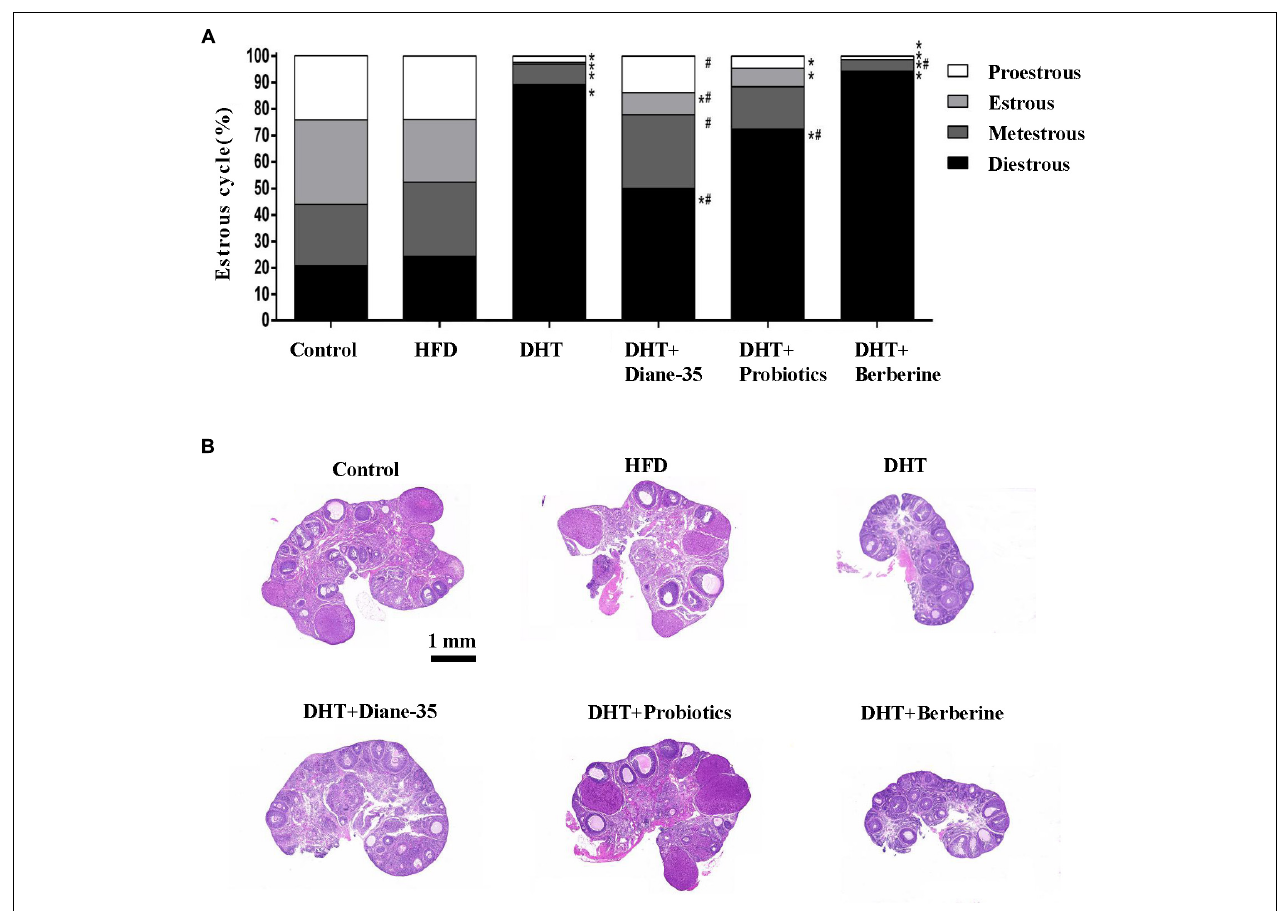
FIGURE 2 | (A) The proportion of different estrous cycle stages in the six groups was analyzed using the Chi-square test, and differences were evaluated by z -test. ∗ p < 0.05 vs. controls, # p < 0.05 vs. DHT. (B) H&E staining of the ovary in the control, HFD, DHT, and three treatment groups.